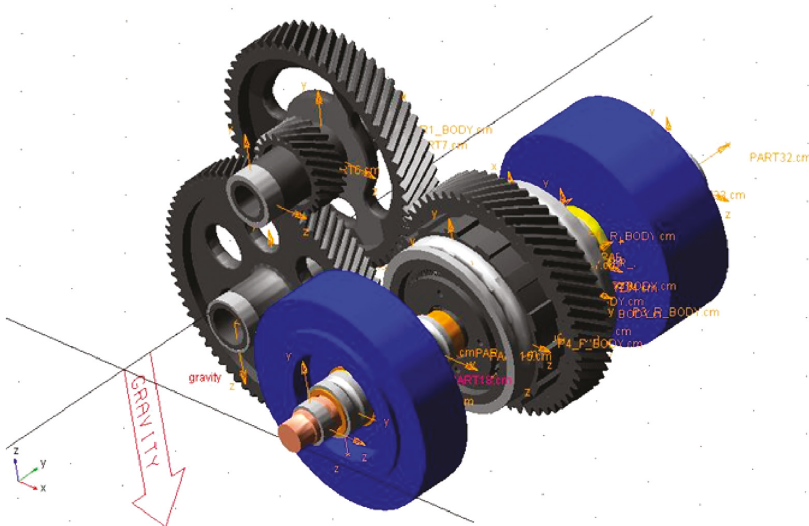
Figure 2: Dynamic model with rigid and flexible components. Table 3: Data obtained in road tests.